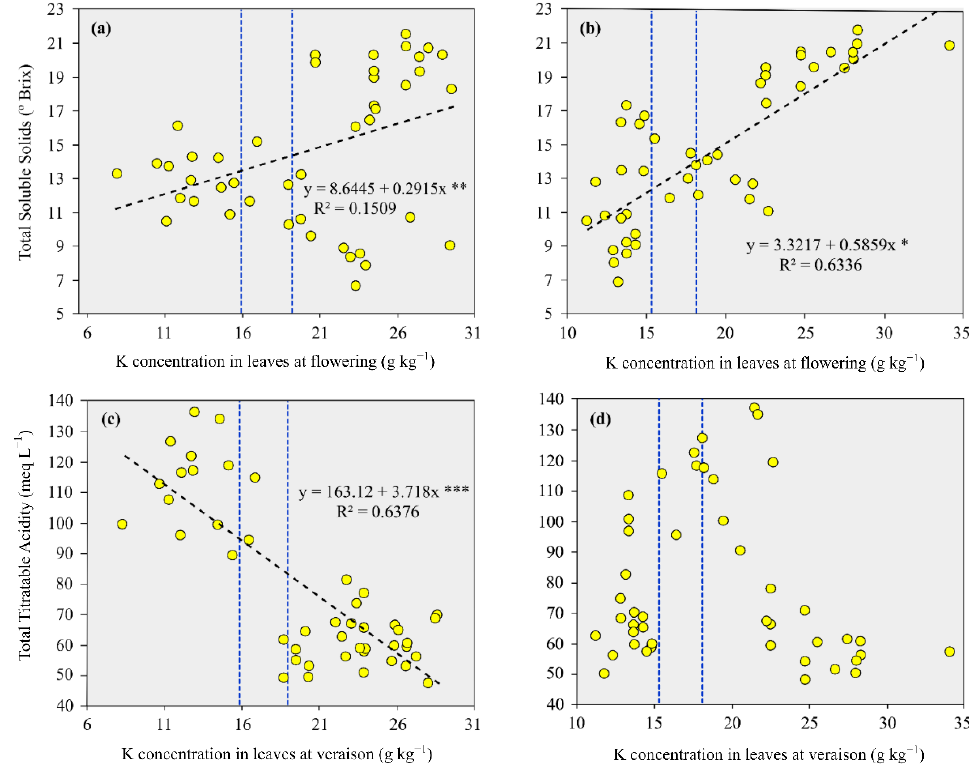
Figure 4. The relationship between the total soluble solids (TSS) and the K concentration in the leaves ( a , b ) and between the total titratable acidity (TTA) and the K concentration in the leaves ( c , d ) at flowering and veraison, in 2016/17, 2017/18 and 2018/19, in the cultivar ‘Chardonnay’ submitted to soil-applied K fertilization. Vertical blue dotted lines represent the range of probability of occurrence (95% highest density interval) of the CL of K. Black dotted lines show the behavior of the equation (TSS and TTA variables). “*” Significant at 5% ( p < 0.05). “**” Significant at 1% ( p < 0.01). “***” Significant at 0.1% ( p < 0.001).